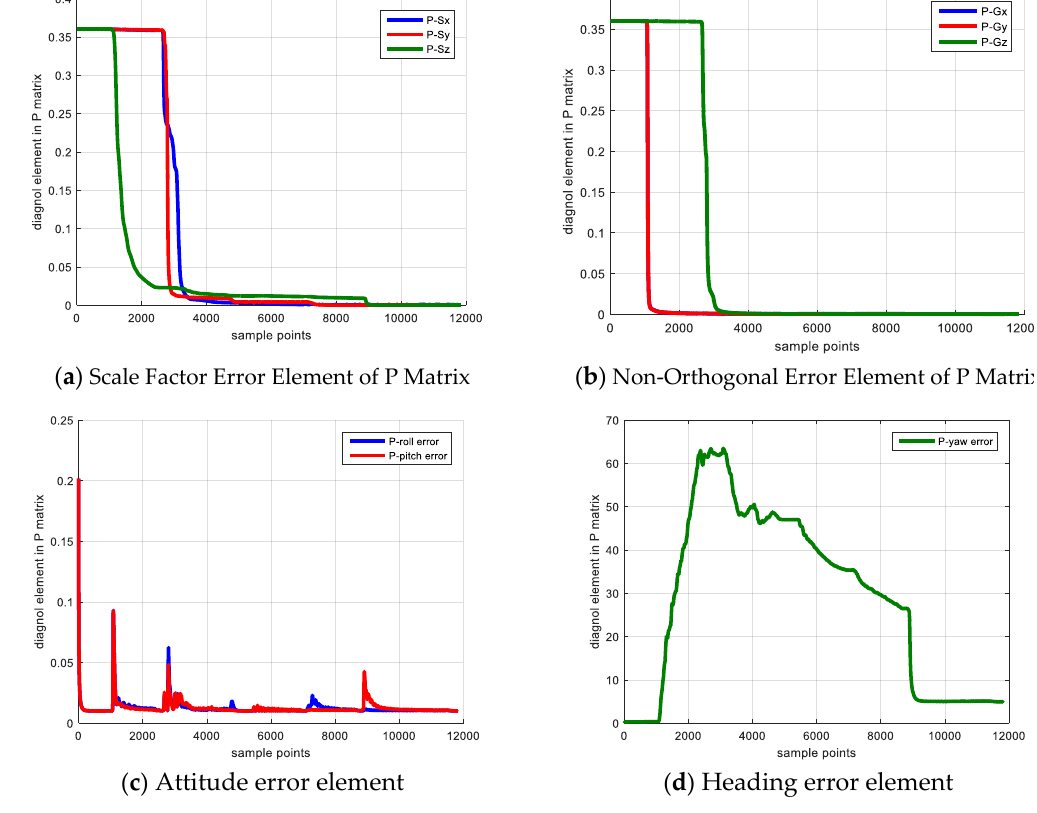
Figure 6. Elements of P Matrix.